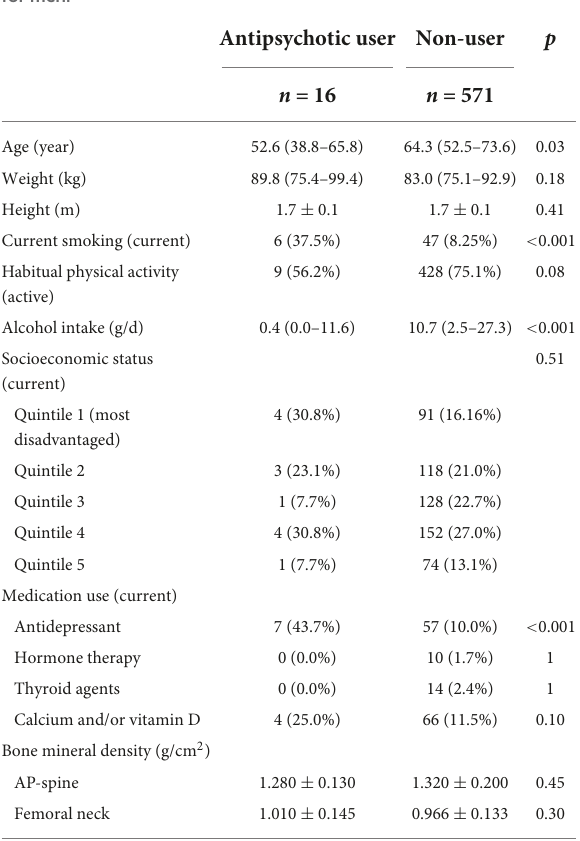
*Best models adjusted for: (cid:85) age, weight, calcium/vitamin D, and smoking, £ age, weight, andsmoking , § age,weight,calcium/vitaminD,andbisphosphonate. β ,regressioncoefficient;SE,standarderror. TABLE 3 Characteristics of antipsychotic users and non-users for